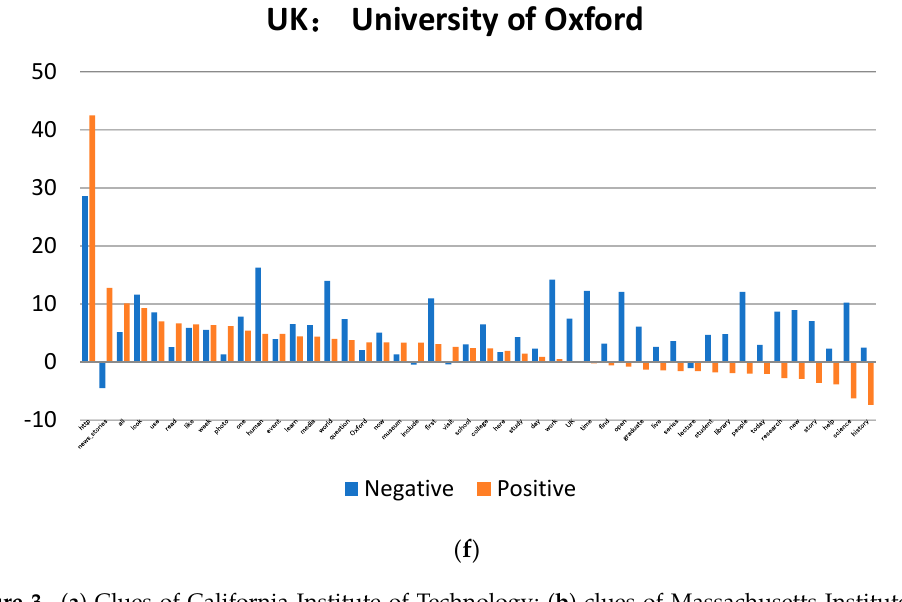
Figure 3. ( a ) Clues of California Institute of Technology; ( b ) clues of Massachusetts Institute of Technology; ( c ) clues of Stanford University; ( d ) clues of Imperial College London; ( e ) clues of University of Cambridge; ( f ) clues of University of Oxford.